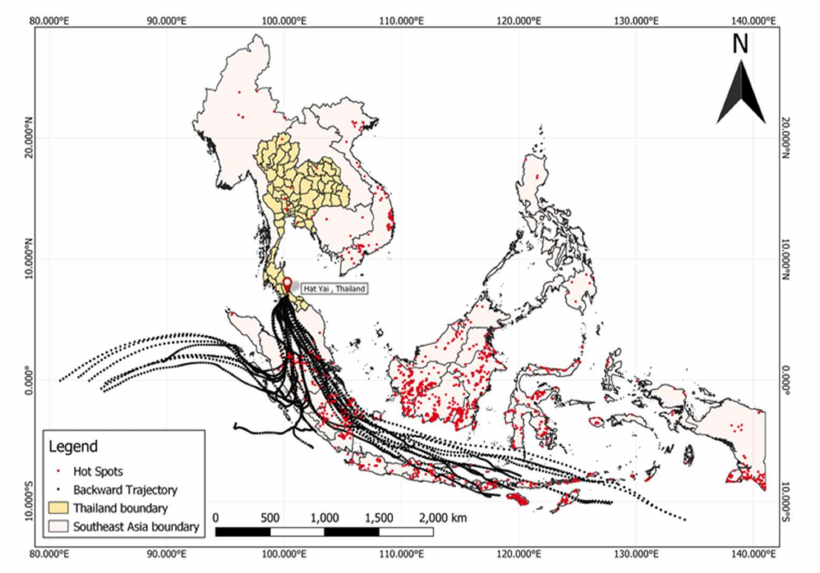
Figure 3. Distribution of hot spots and air mass trajectories during the high episode (August